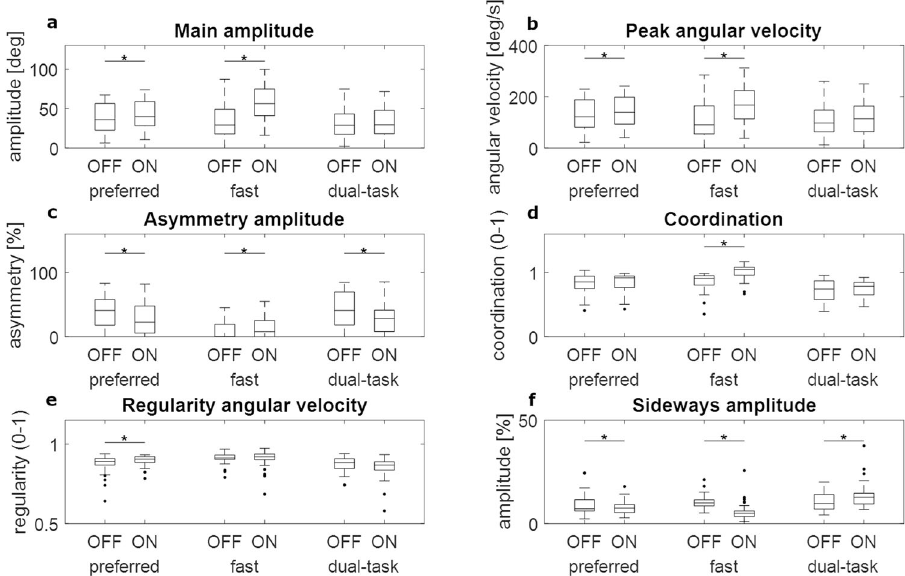
Fig. 1 Arm swing parameters during the different medication states and different walking conditions. a Main amplitude, b Peak angular velocity, c Asymmetry of the amplitude, d Coordination between the arms, e Regularity of the angular velocity and f amplitude of the sideways arm swing. * above horizontal lines, connecting different box plots = P < 0.05 between medication states. All data are corrected for gait speed. Center line: median; box limits: upper and lower quartiles; whiskers: 1.5 × interquartile range.